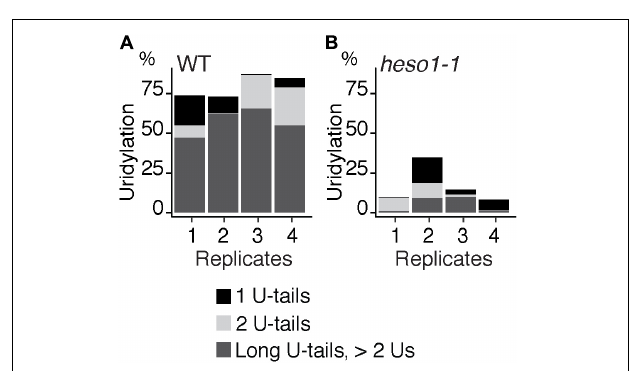
FIGURE 3 | HESO1 is the main TUTase uridylating MYB33 RISC 5 (cid:48) -cleavage fragments. Percentages of uridylated MYB33 RISC 5 (cid:48) -cleavage fragments in four biological replicates for (A) WT and (B) heso1-1 . Percentages of long ( > 2 Us), 2 U- and 1 U-tails are indicated by dark gray, light gray, and black,